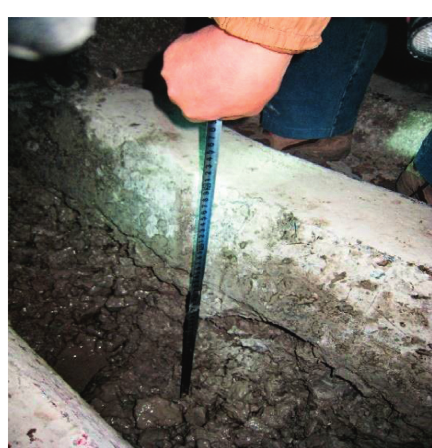
Figure 4: Track bed